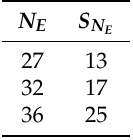
Table 3. Table of S N